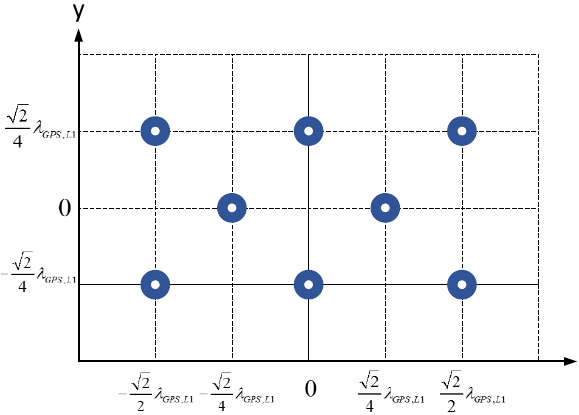
Figure 2. Geometry of the dual-frequency antenna array for GPS L1 and BDS B3 signals. The distance between the two nearest antenna elements is one half of the GPS L1 carrier wavelength.